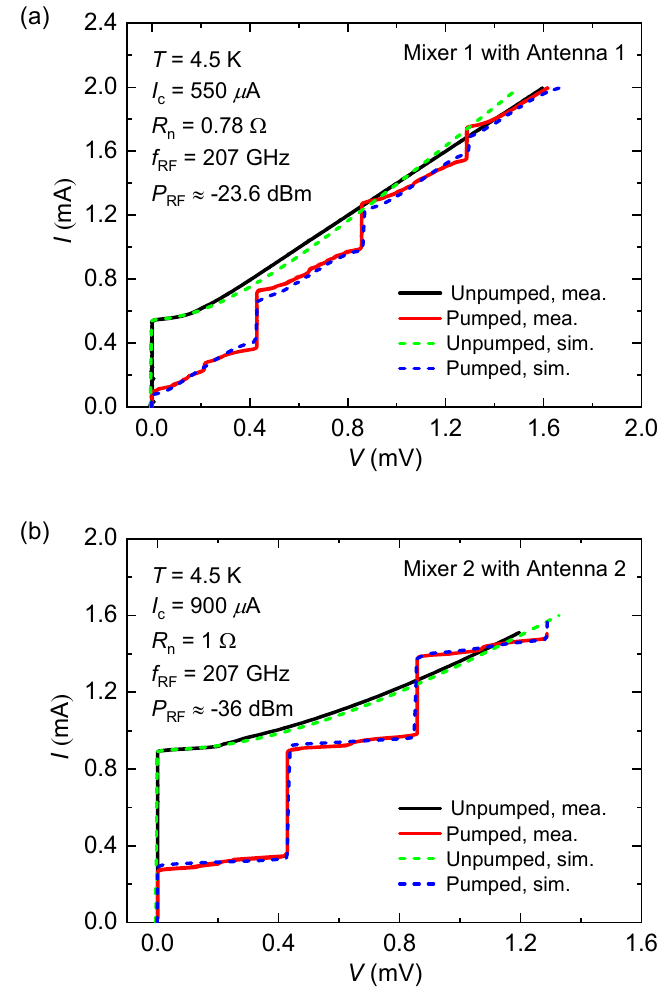
Figure 5. ( a ) Measured and simulated DC IVCs of the JJ Mixer 1 coupled with Antenna 1: bowtie loaded by a pair of lumped-element stubs under a 0.21 THz signal radiation or not at the bath temperature about 4.5 K. ( b ) Measured and simulated DC IVCs of the JJ Mixer 2 coupled with Antenna 2: bowtie loaded by a pair of open-end stubs under a 0.21 THz signal radiation or not at the bath temperature about 4.5 K.